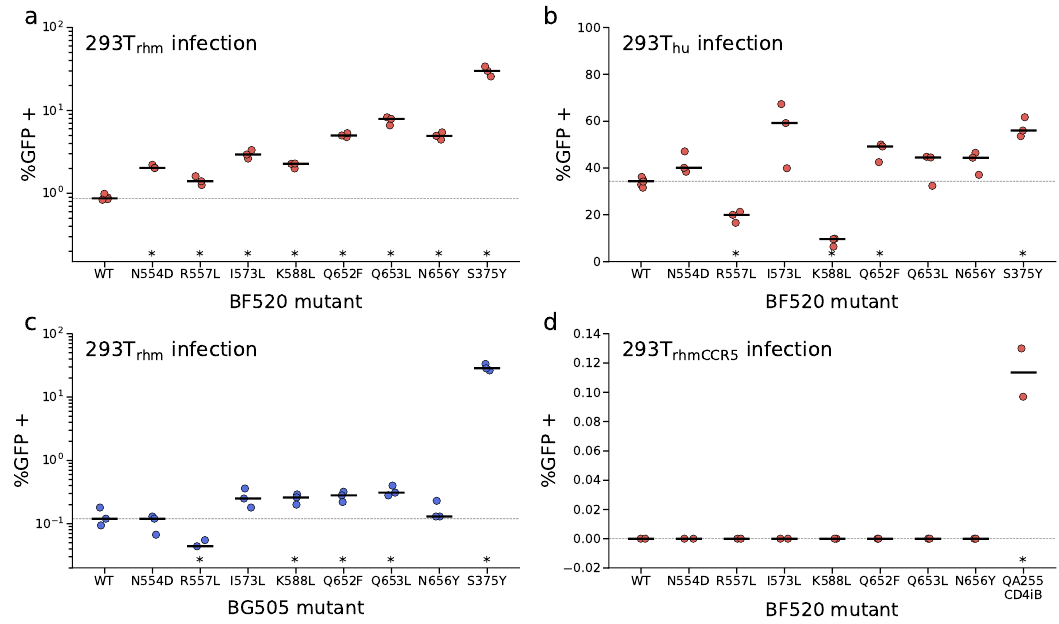
Figure 3. Infection of 293T rhm , 293T CCR5, and 293T hu cells by point mutant pseudoviruses. Each panel reports the percentage of the indicated cells that were GFP positive 48 h post-infection (MOI of 5) with the indicated wild-type or mutant viruses. The Env strain in which mutants were engineered is shown at the bottom of each panel. Every point in each panel represents one experimental replicate, and the median, indicated as a horizontal black bar, is representative of at least two independent experiments. Asterisks indicate mutants whose infection was significantly di ff erent than the wild-type ( p < 0.05, Welch’s t-test). ( a ) Infection of 293T rhm by point mutants in the BF520 Env background. ( b ) Infection of 293T hu by point mutants in the BF520 Env background. ( c ) Infection of 293T rhm by point mutants in the BG505 Env background. Note that infection of these cells by wild-type BG505 is nearly 10-fold less e ffi cient than by wild-type BF520. ( d ) Infection of 293T rhmCCR5 by point mutants in the BF520 Env background. QA255 CD4iB is a CD4-independent Env described in [10] used here as a positive